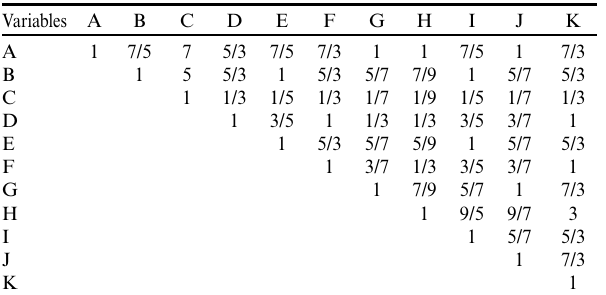
The priority vector in Table 6 was obtained by determining the row averages. For example, the priority of the first driving